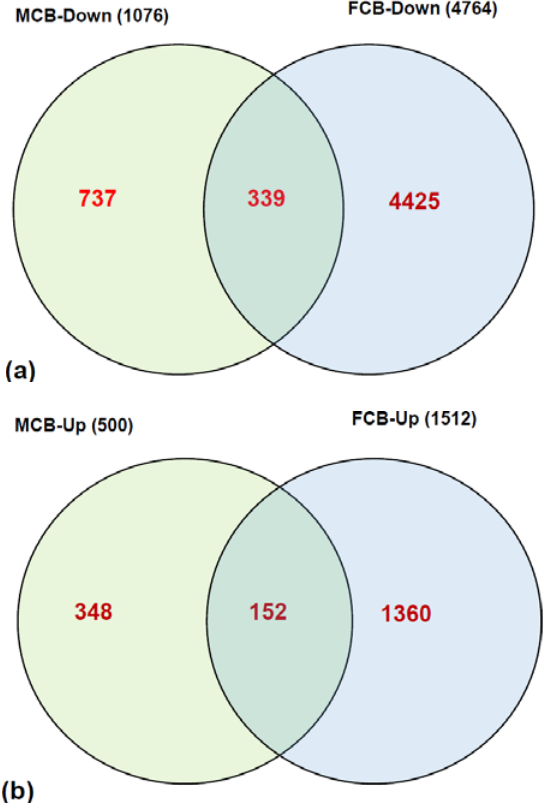
Figure 1. Overview of differential gene expression in the cerebellum of P1 pups. The distribution of ( a ) down-regulated genes, as well as ( b ) up-regulated genes, between male (MCB) and female (FCB) pups from higher gestational